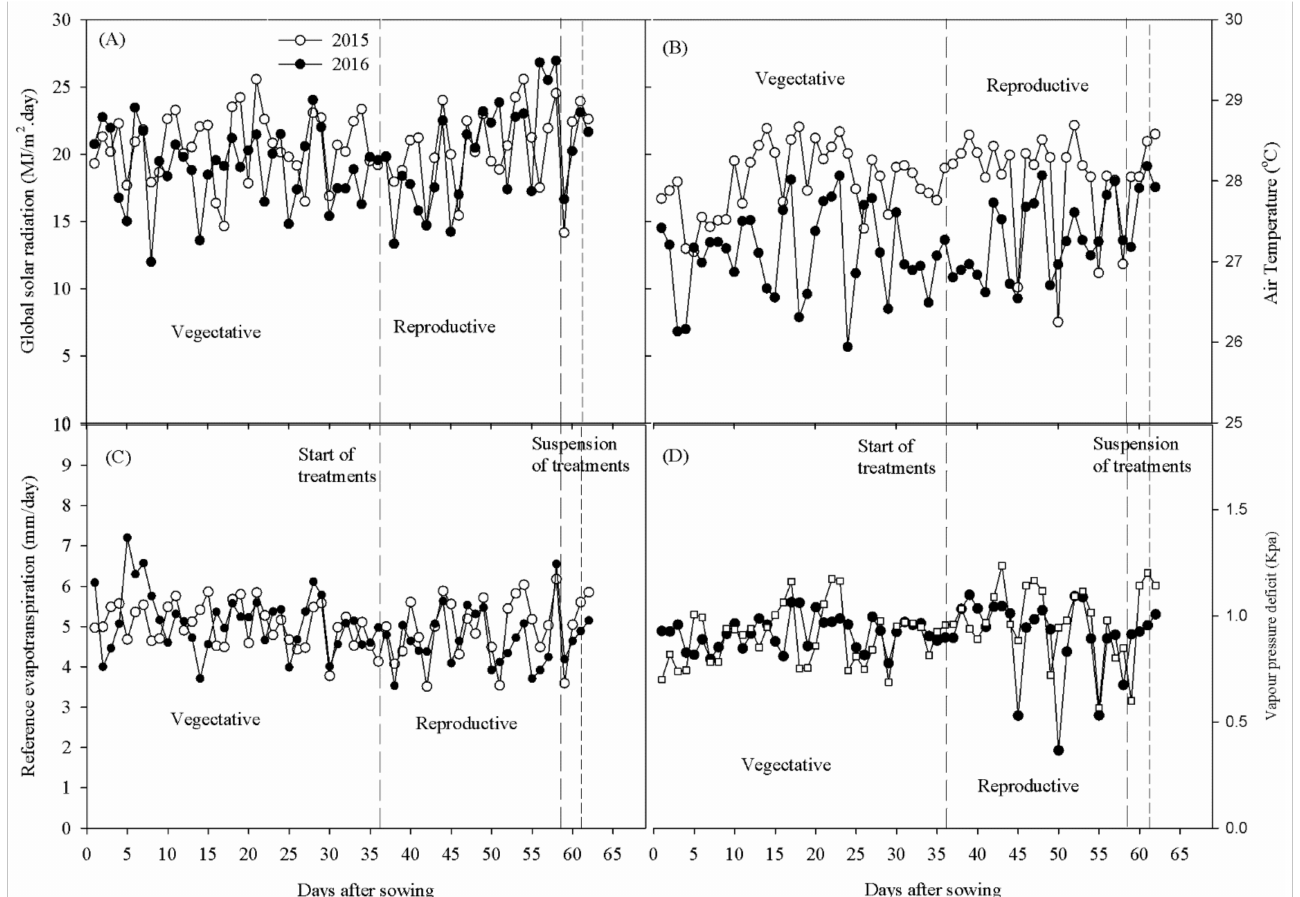
Figure 1. Meteorological conditions during the experimental period in 2015 and 2016. Global solar radiation ( A ), air